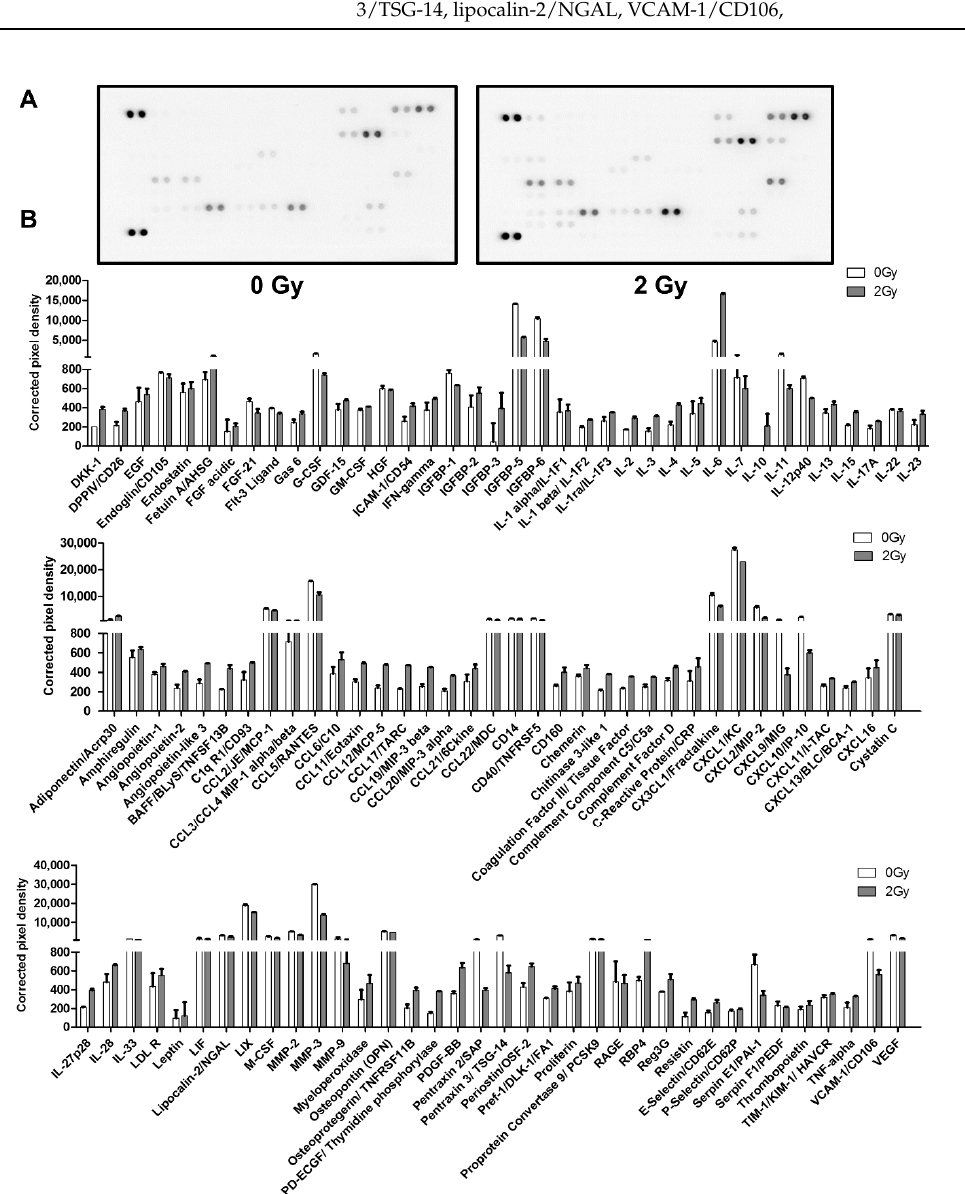
Figure 3. Radiation-induced senescent MLO-Y4 cells secrete multiple SASP components. ( A ) Mouse cytokine microarray membrane analysis was performed to detect the composition of osteocyte SASP in the culture medium of MLO-Y4 cells post irradiation. ( B ) Quantified expression levels of the 111 detected cytokines, expressed as corrected pixel density ( n = 2). Results are expressed as mean ±